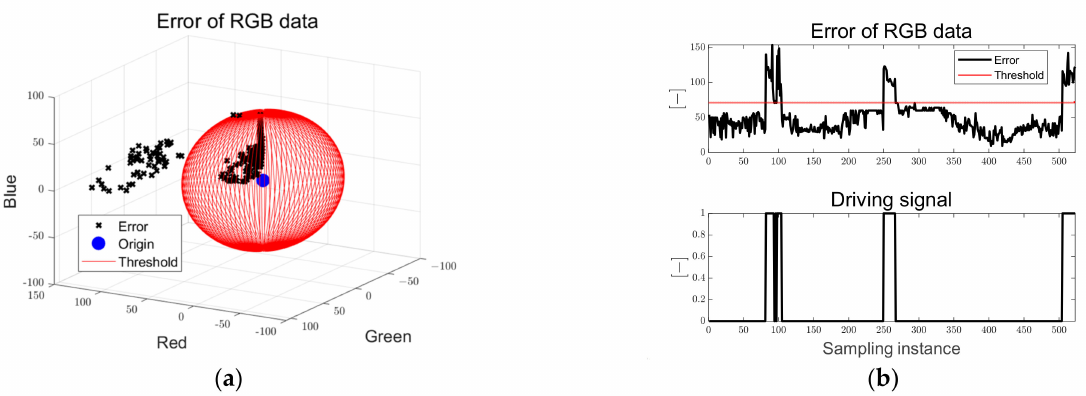
Figure 14. Ellipse path tracking scenario results; ( a ) error of RGB data; ( b ) driving flag signal.